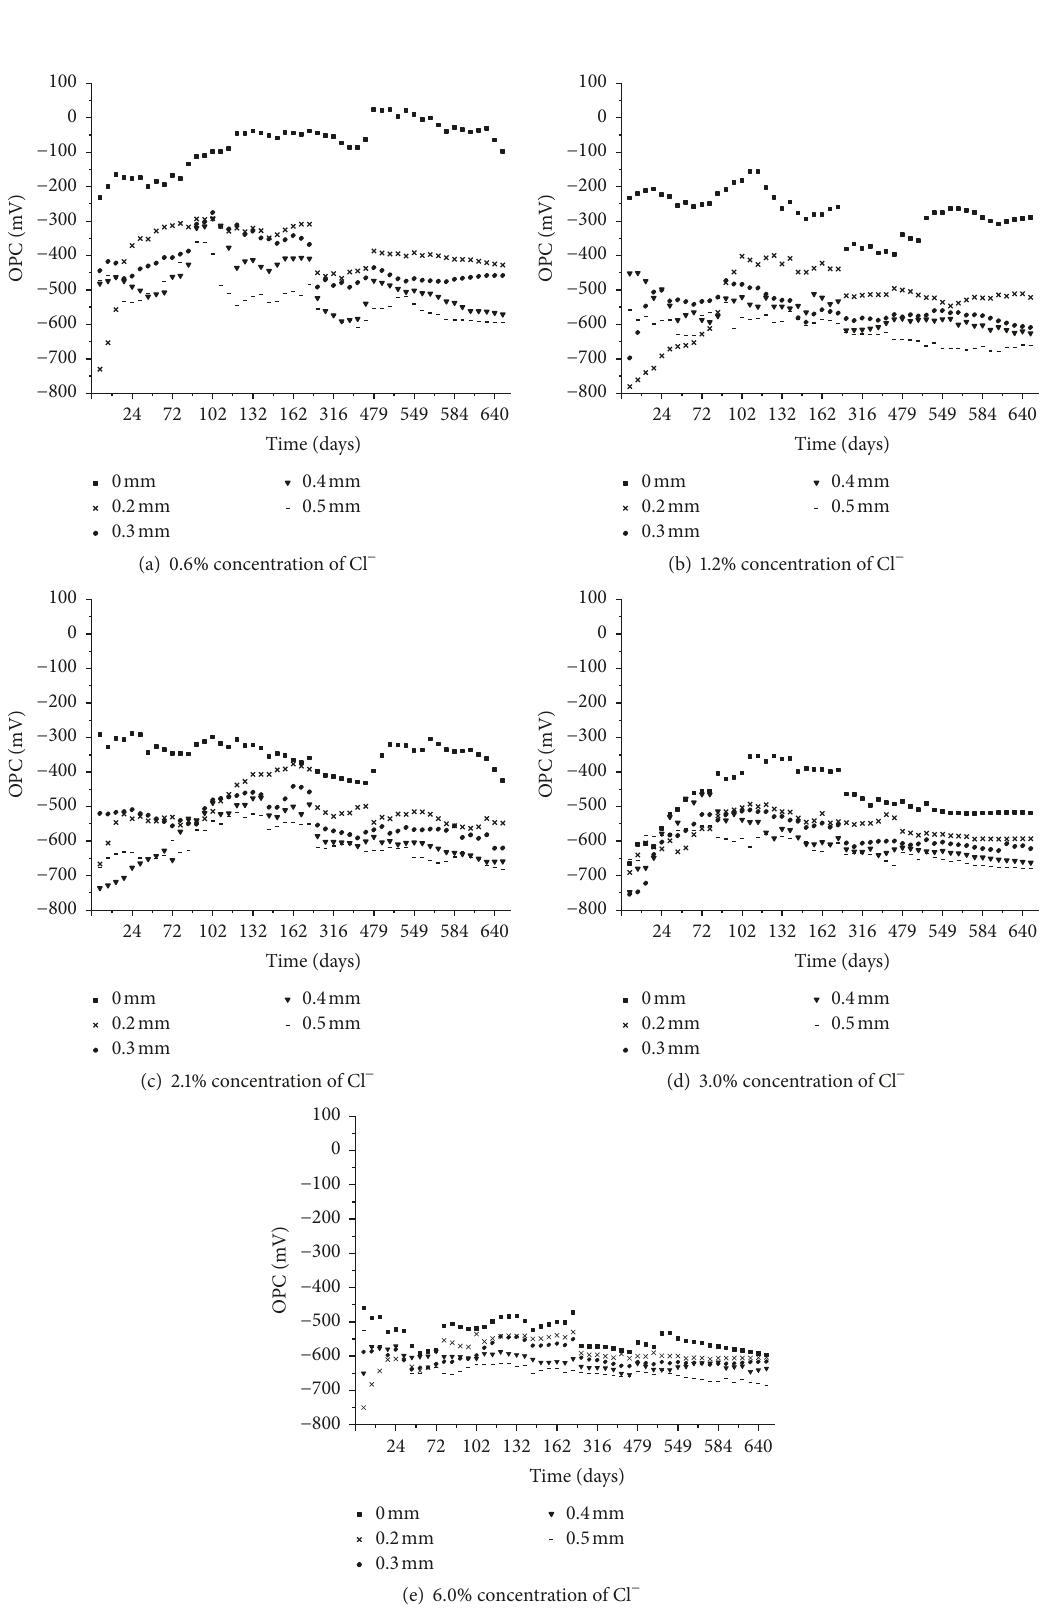
Figure 11: Time-development of the open circuit corrosion